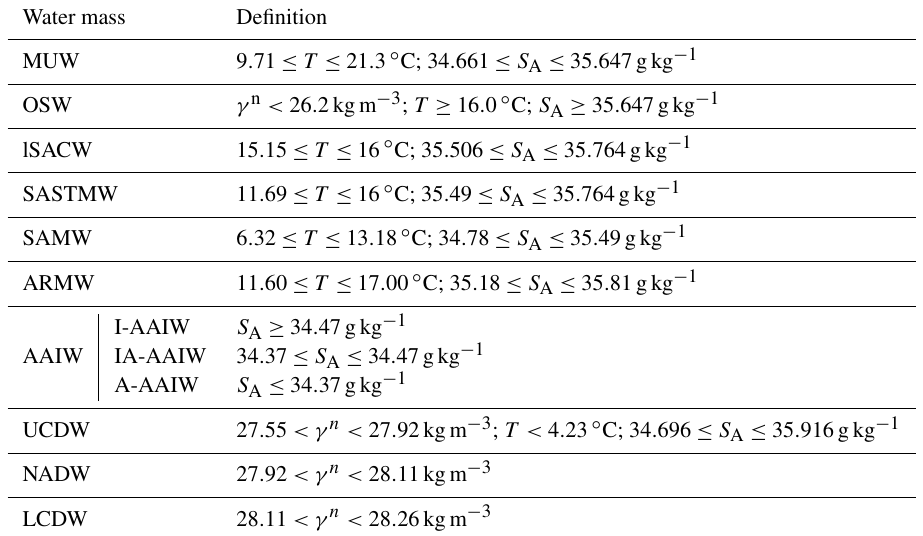
Table 5. Table with the different water masses and their definition in terms of conservative temperature, absolute salinity and density layers. Water